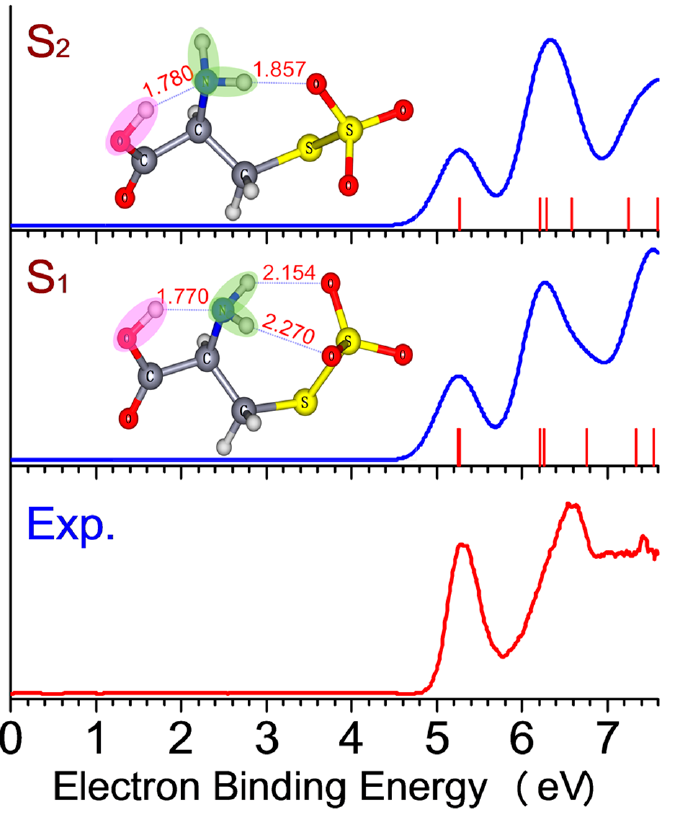
Figure 3. Comparison of the experimental spectrum (red curve) with simulated stick (thin red) and convoluted spectra (blue curves) of the most stable, nearly iso-energetic conformers of [cysS-SO 3 ] − ( S 1 and S 2 ). The simulations were based on the time-dependent (TD) CAM-B3LYP calculations using Gaussians with full widths at a half maximum of 350 meV and the first stick that represents the transition to the ground state of the neutral shifted to match the calculated VDEs. The rest of sticks at higher EBE in simulations correspond to the excited states of the neutral at the anion geometry (for simulated spectra for other isomers, see Figure S3).